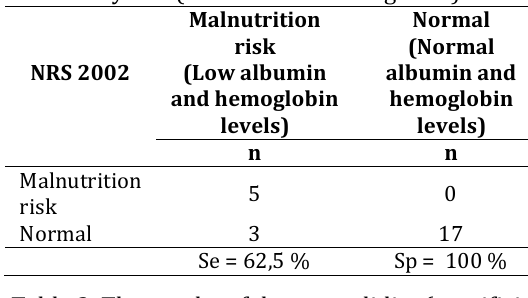
Table 2. The results of the test validity (specificity and sensitivity) on the use of the Malnutritional Universal Screening Tool (MUST) used to calculate the risk of malnutrition as seen from the